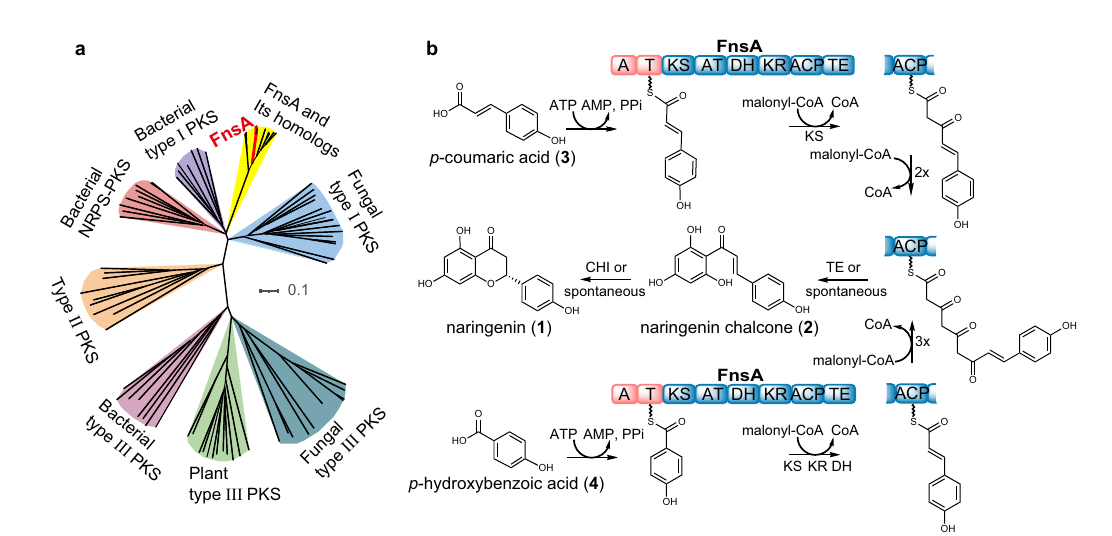
Fig. 5 | Phylogenetic analysis of the FnsA KS domain and the proposed bio- synthetic pathway ofnaringenin in P. fi ci . a Phylogenetic analysis ofthe FnsA KS domain and functional characterized KS domains from plants, bacteria, and fungi.